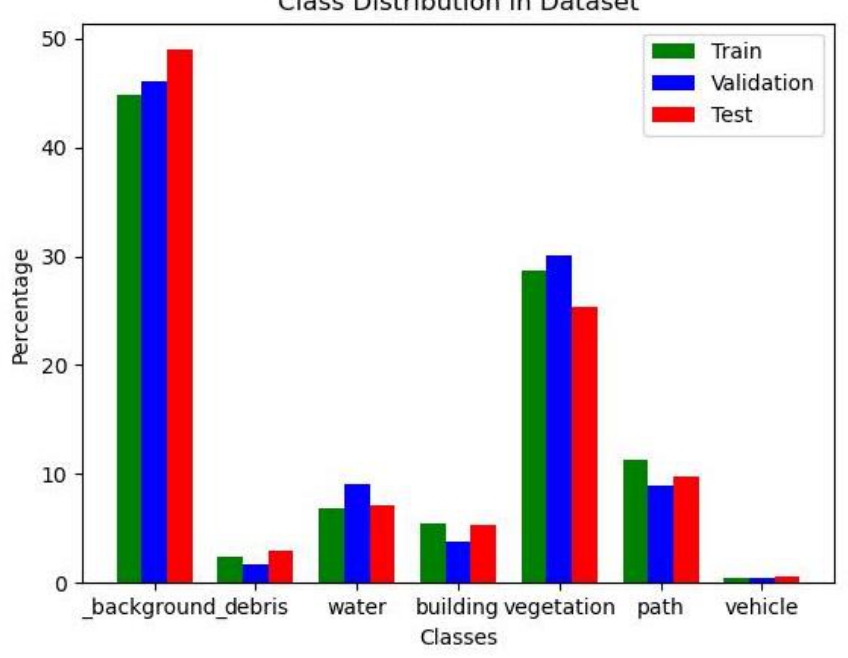
Figure 13. Distribution of pixels for each class in the Hurley dataset.